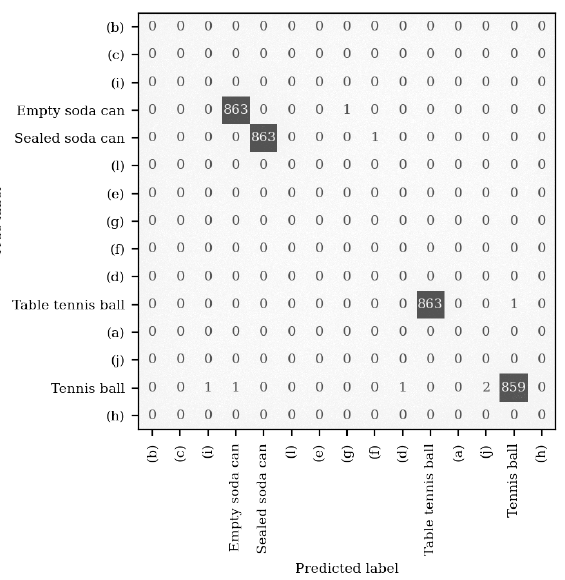
Figure 10. The confusion matrix of the test set used to assess the ability of the technique to detect broader classes of